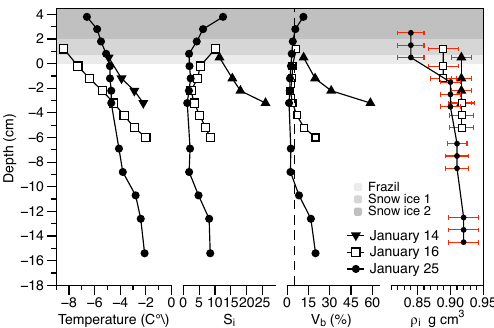
Figure 5. Ice in situ temperature ( ◦ C), bulk ice salinity, and brine volume fraction ( V b ) and bulk ice density profiles (gcm − 3 ) on 14, 16, 25 January. The dotted line at 5% on the V b panel refers to the theoretical liquid permeability threshold for columnar sea ice (Golden et al., 1998). Red bars on the density profiles indicate the standard deviation of the mean of density measurements derived from the mass–volume